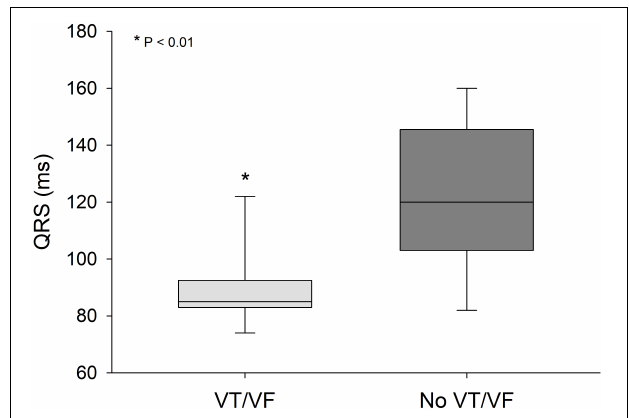
FIGURE 3 | QRS values were significantly lower ( p < 0.01) in patients that developed VT/VF after first ECG-recording compared to patients that remained in sinus rhythm. Solid line: Median, box-plot: 25- to 75-persentile, and error bars: 5- and 95-persentile. *Difference from «No VT/VF group» ( p < 0.05). VF, ventricular fibrillation; VT, ventricular tachycardia.